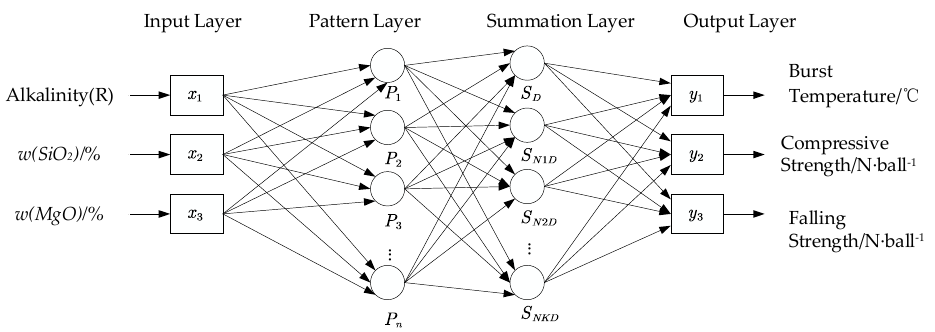
Figure 4. Prediction model of green pellet performance.